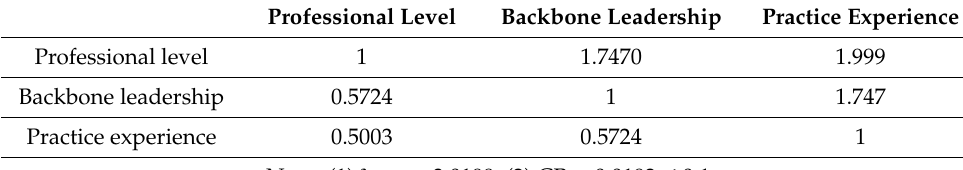
Table 7. Aggregate pair-wise comparison matrix for criteria of level 2.